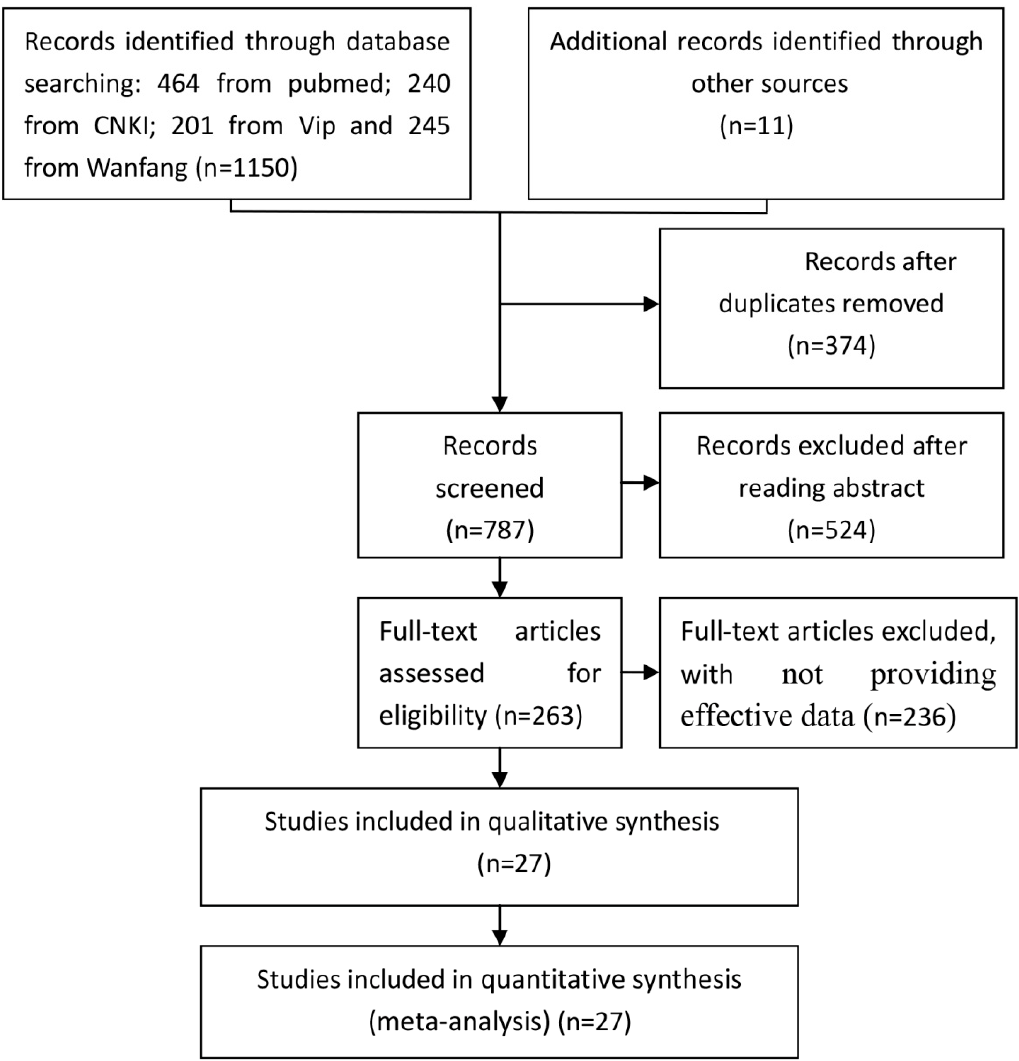
Figure 1. Flowchart of the selection of studies for inclusion in the meta-analysis Abbreviations: CNKI: Chinese National Knowledge Infrastructure; Vip: vip database; Wanfang: Wanfang data; and HCC: hepatocellular carcinoma.